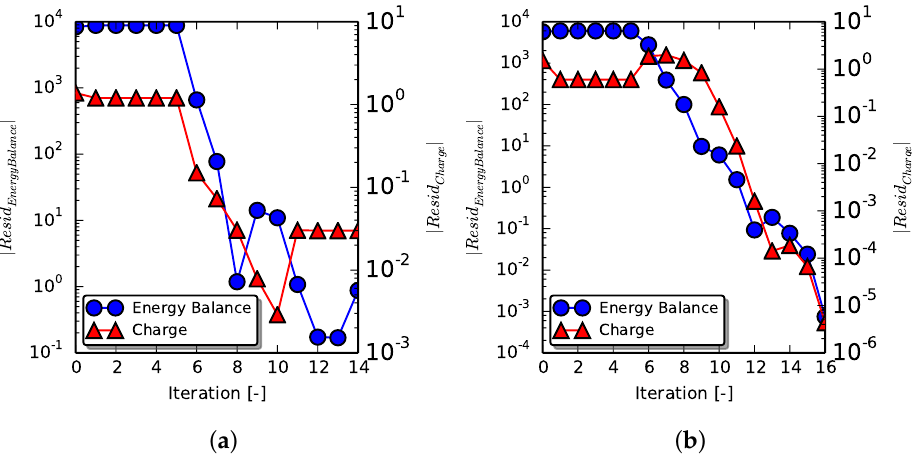
Figure 15. Examples of convergence history for the ORC with R245fa using the charge-based solver: ( a ) partial convergence; ( b ) full convergence.